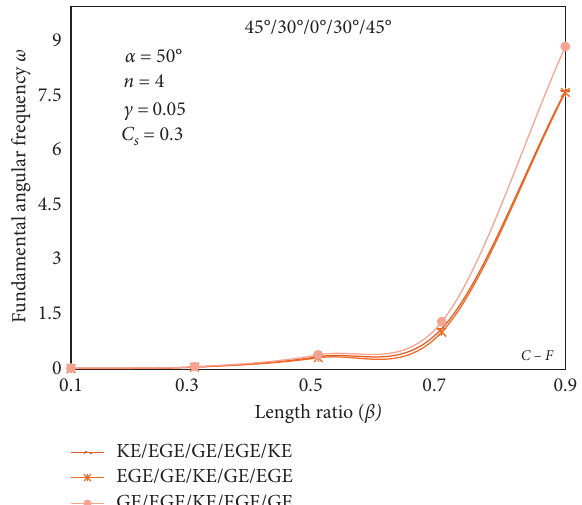
01.534.567.5910.512